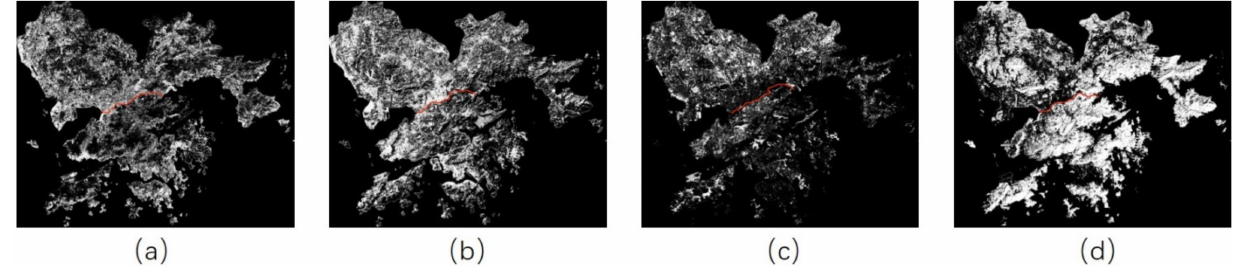
Figure 6. Linear spectral un-mixing of Hong Kong and Shenzhen in 2016: ( a ) high-albedo; ( b ) low- albedo; ( c ) soil; ( d ) vegetation.